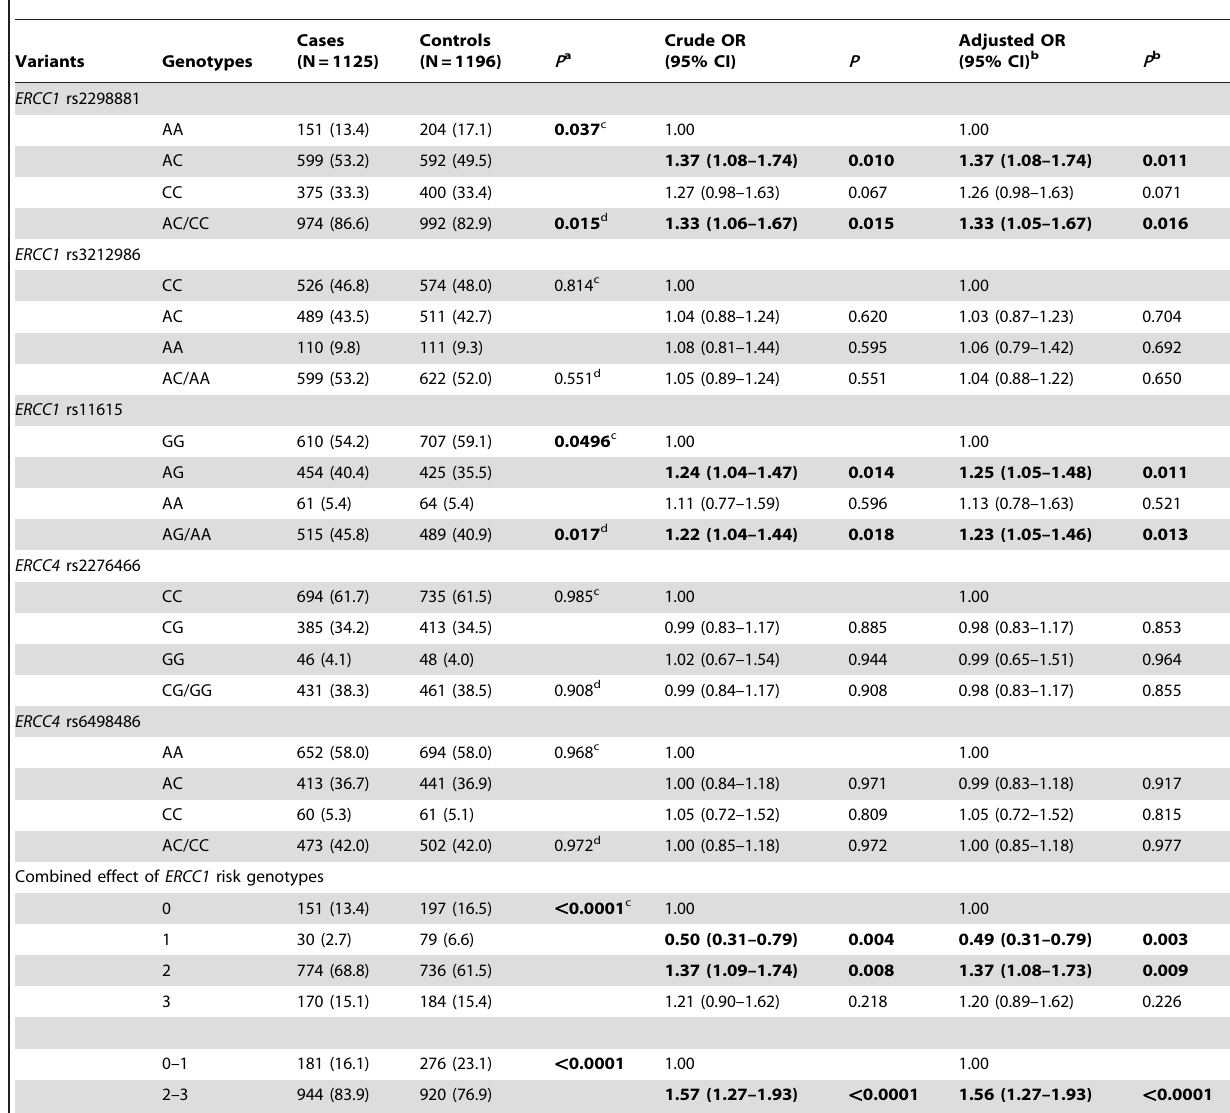
Table 1. Logistic regression analysis of associations between selected ERCC1 and XPF/ERCC4 SNPs and gastric cancer risk in an Eastern Chinese